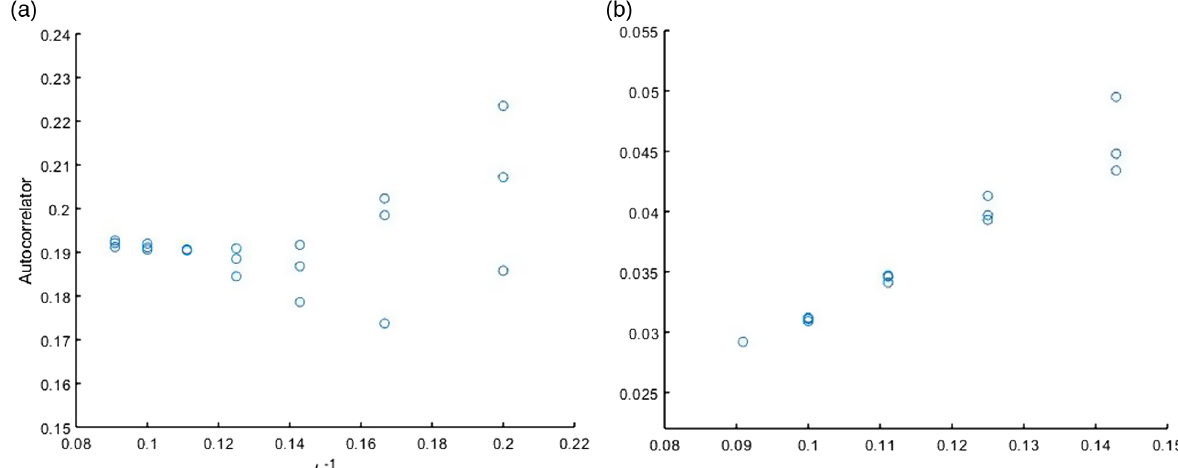
FIG. 3. Late-time value of the autocorrelation function h S z;i ð t Þ S z;i ð 0 Þi − ½ 2 = ð 3 L Þ(cid:2) as a function of inverse system size L − 1 for three-site and four-site gates. Results are obtained with the brute-force code, with t ¼ 1000 . The correlation function is defined as h S ð t Þ S ð 0 Þi ¼ ð 1 = 3 L Þ Tr ½ S z O ð t Þ(cid:2) , where O ð 0 Þ ¼ … I ⊗ I ⊗ S z ⊗ I ⊗ I … and the initial S z is on a site i in the middle of the z;i z;i i chain. In both cases, three runs are plotted for each system size to illustrate the size of fluctuations, which become negligible at larger system sizes. No renormalization is performed, so h S z;i ð t ¼ 0 Þi ¼ 2 = 3 . (a) Autocorrelator as a function of inverse system size for three site gates, (b) Autocorrelator as a function of inverse system size for four site gates.